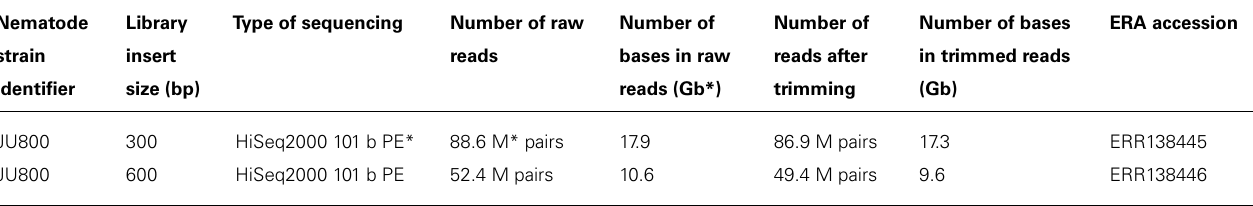
Table 2 | Sequence data for Caenorhabditis sp. 5.